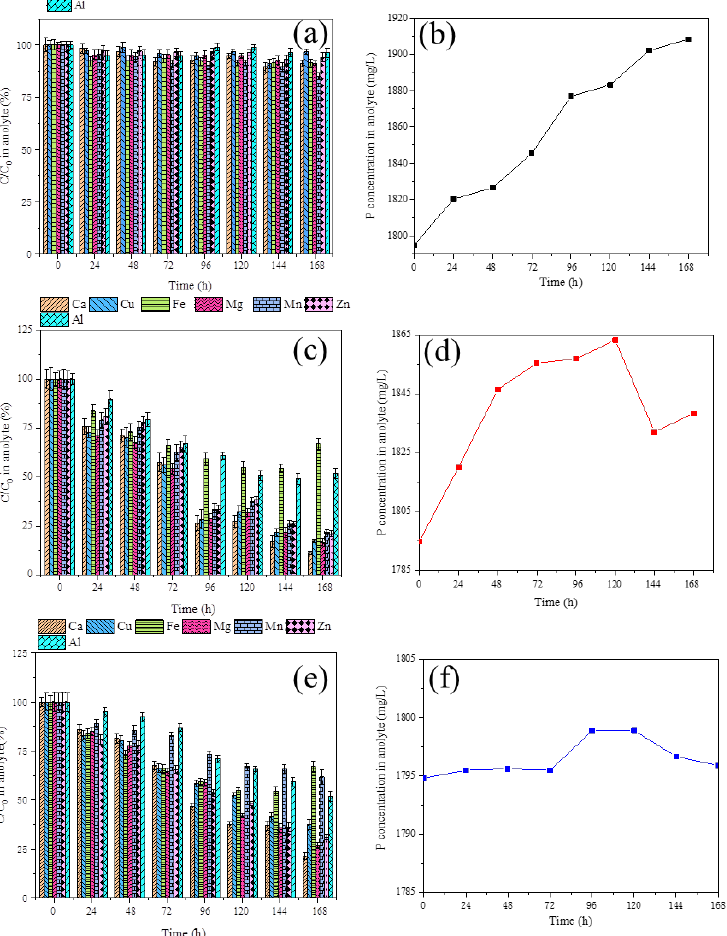
Figure 3. Residual percentage of heavy metals/metals in anolyte (current of 15 mA ( a ), 35 mA ( c ) and 50 mA ( e )) and P concentration changes in anolyte (current of 15 mA ( b ), 35 mA ( d ) and 50 mA ( f )). Differences are observed in P concentration variation among these three